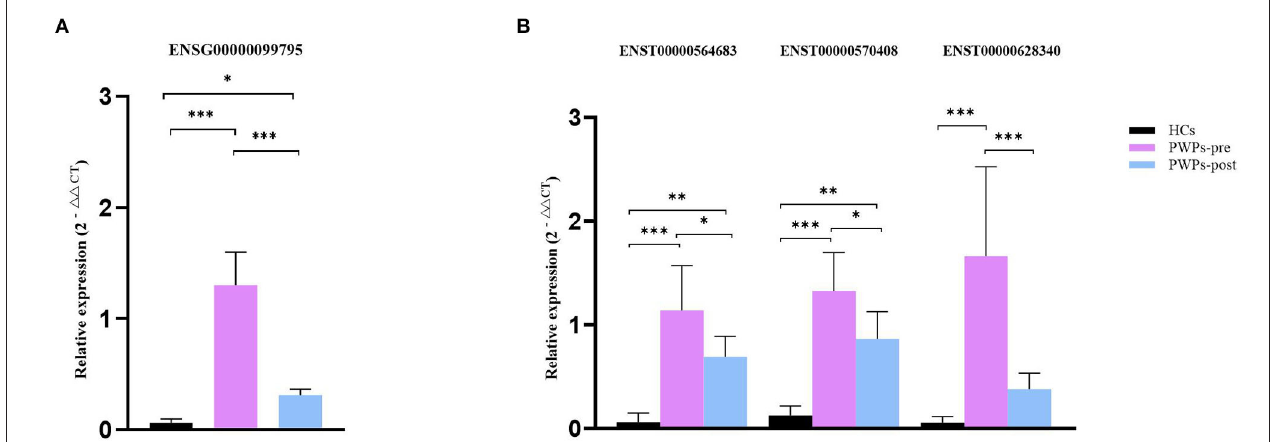
FIGURE 7 | qRT-PCR validation of differentially expressed mRNA and lncRNAs. qRT-PCR verification of the expression profiles of NDUFB7 mRNA (A) and 3 related lncRNAs (B) in HCs, pre- and post-rehab PWPs. ∗ P < 0.05, ∗∗ P < 0.01, ∗∗∗ P < 0.001. Pre-rehab, pre-rehabilitation; post-rehab, post-rehabilitation; PWPs, patients with Parkinson’s